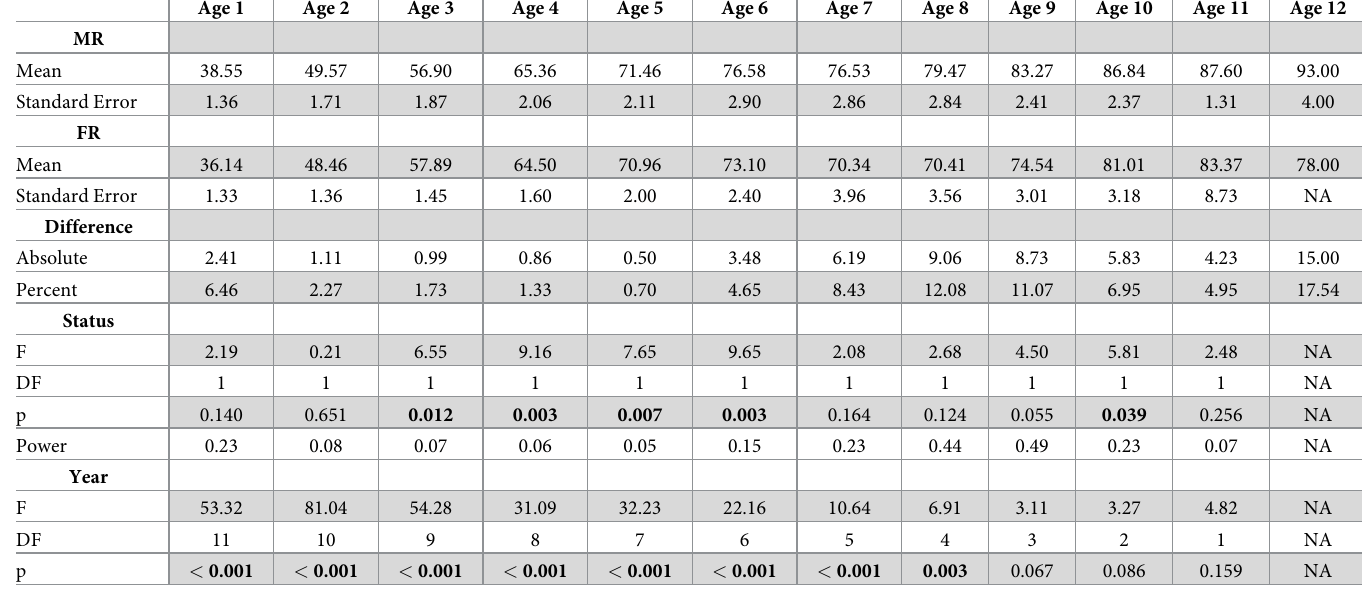
Table 2. A . nigrofuscus mean lengths and standard errors of the mean in millimeters for each age cohort separated by management status, along with two-way ANOVA F-values (F), degrees of freedom (DF), and p-values (p) for both status and year effects. Power of each age cohorts’ spatial analysis is additionally presented. Significant values indicated in bold.